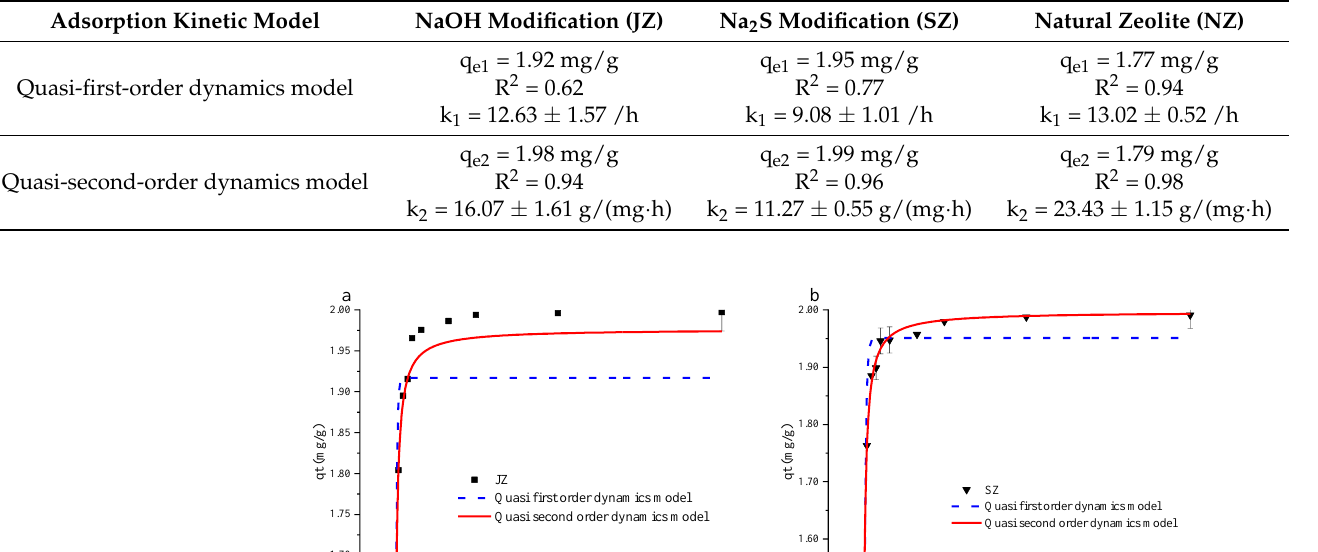
Table 2. Adsorption kinetic equation parameters of modified and natural zeolite.